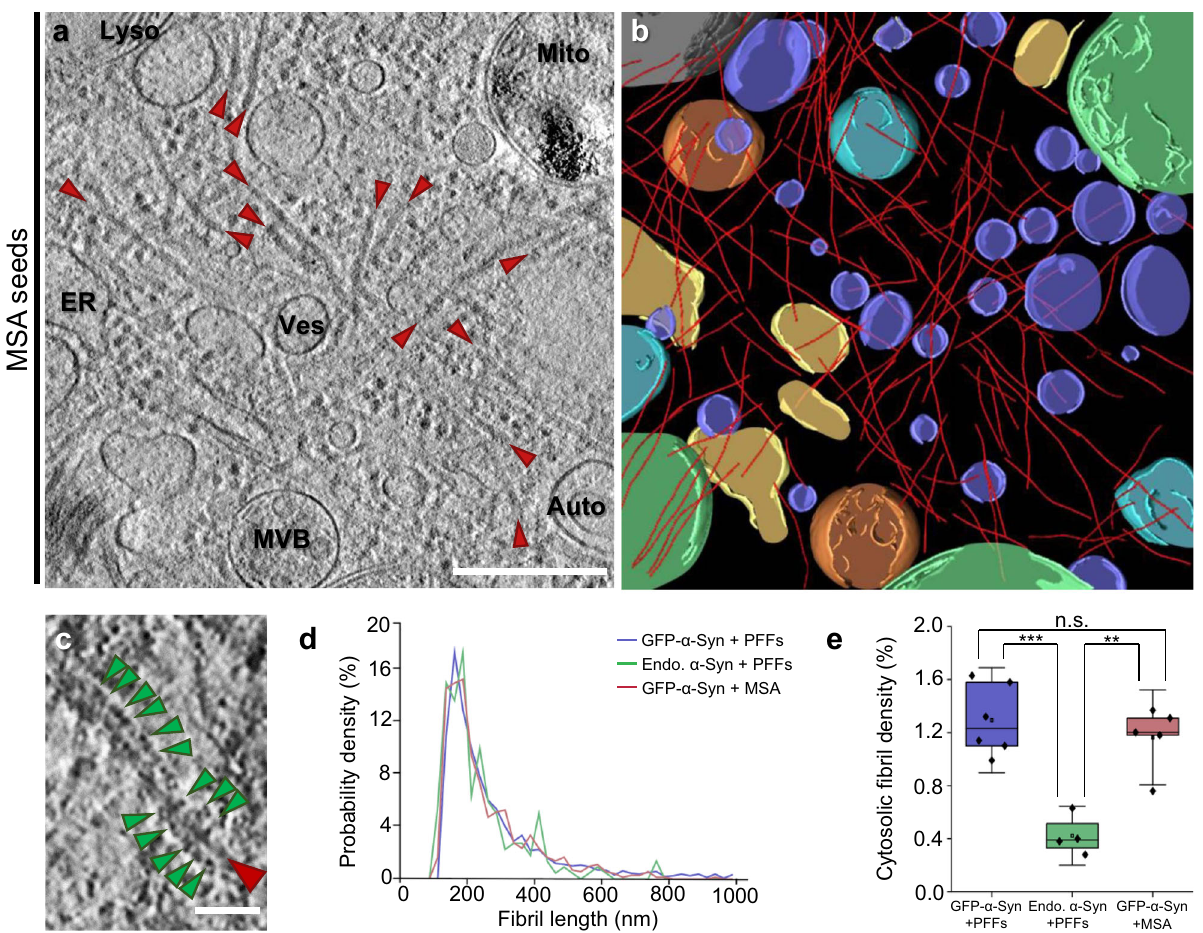
Fig. 2 Cryo-ET imaging of α -Syn aggregates seeded by MSA patient brain material in neurons. a A tomographic slice (thickness 1.4 nm) of an inclusion seeded by MSA patient brain material in a neuron expressing GFP- α -Syn. Auto; autophagosome, ER; endoplasmic reticulum, Lyso; lysosome, Mito; mitochondrion, MVB; multivesicular body, Ves; vesicles. Fibrils are marked by red arrowheads. Scale bar: 350 nm. b 3D rendering of the tomogram depicted in a showing α -Syn fi brils (red), autophagosomes (cyan), ER (yellow), a lysosome (gray), mitochondria (green), multivesicular bodies (orange), and various vesicles (purple). c Magni fi ed view of a fi bril with GFP-like densities (green arrowheads) decorating the fi bril core. Scale bar: 30 nm. d Histogram of fi bril length. n = 1592 (GFP- α -Syn + PFFs), 220 (endogenous α -Syn + PFFs), and 721 (GFP- α -Syn + MSA) fi brils analyzed over three biologically independent experiments for all conditions. e Box plots of cytosolic fi bril density within inclusions, de fi ned as the fraction of cytosolic volume occupied by fi brils. The horizontal lines of each box represent 75% (top), 50% (middle), and 25% (bottom) of the values, and a black square the average value. Whiskers represent 1.5× standard deviation and black diamonds the individual data points. n = 6 (GFP- α -Syn + PFFs), 4 (endogenous α -Syn + PFFs), and 5 (GFP- α -Syn + MSA) tomograms analyzed over three biologically independent experiments for all conditions; n.s., ** and *** indicate respectively p = 0.4, p = 0.0010, and p = 4 × 10 − 4 by one-way ANOVA. The number of fi brils, tomograms, and biologically independent cryo-ET experiments is listed in Supplementary Table 1. Representative images are shown in a – c . Source data for d and e are provided as a Source data fi